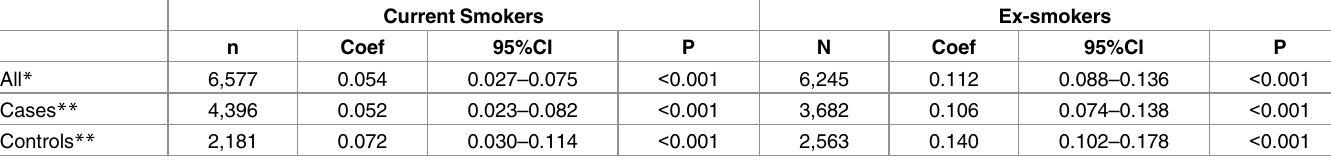
A table for the partial correlation coefficients between BMI and pack-years in smokers. * For all subjects, the analysis was adjusted for age, sex, study sites and disease status. ** For cases and controls, the analyses were adjusted for age, sex, and study